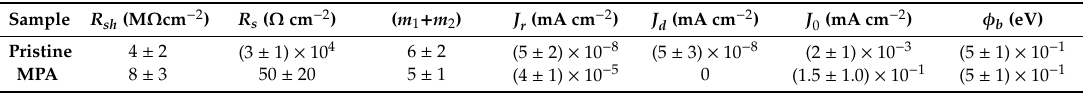
Table 1. Average parameters of the device performances of the prepared thin film CsPbBr 3 PNCs-based photodetectors, as obtained from the di ff erent